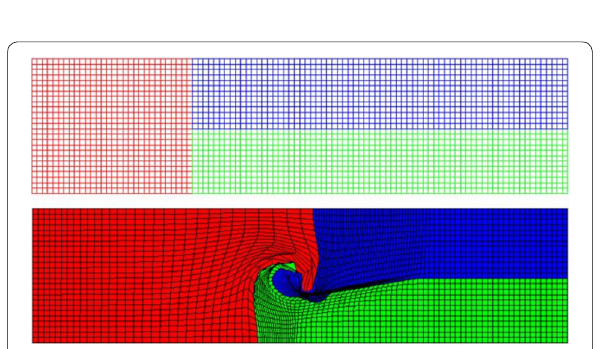
Figure 5 Comparison between the main domain and the Lagrangian formulation